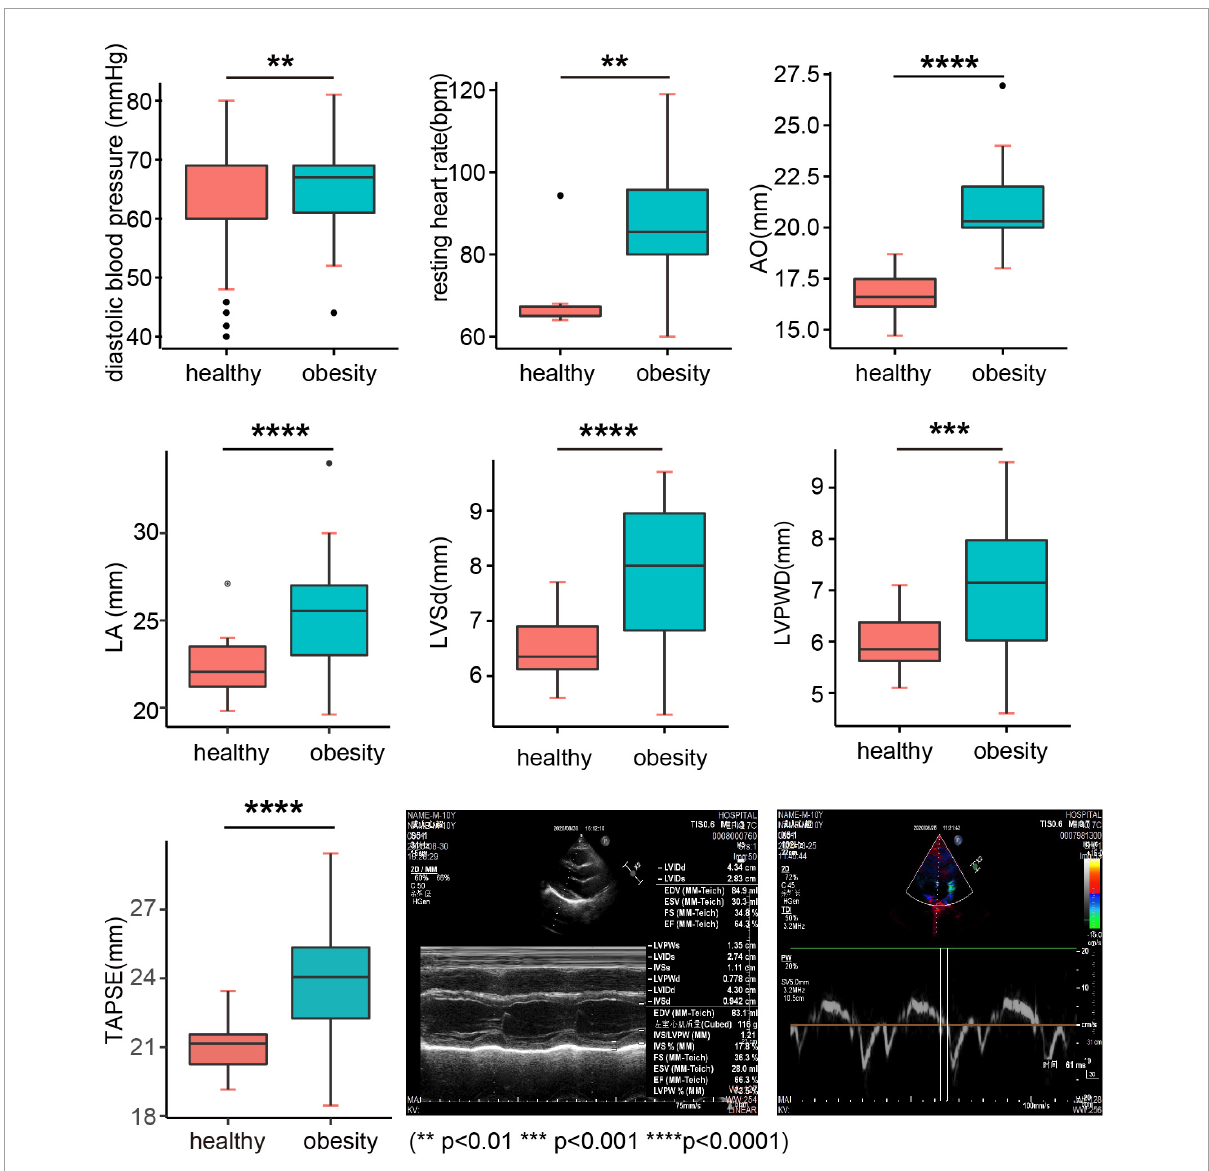
FIGURE4 Cardiovascular functional parameters. AO, aortic annulus; LA, left atrial diameter; IVSd, interventricular septal wall thickness at end diastole; LVPWD, left ventricular posterior wall thickness at end diastole; TAPSE, tricuspid annular plane systolic